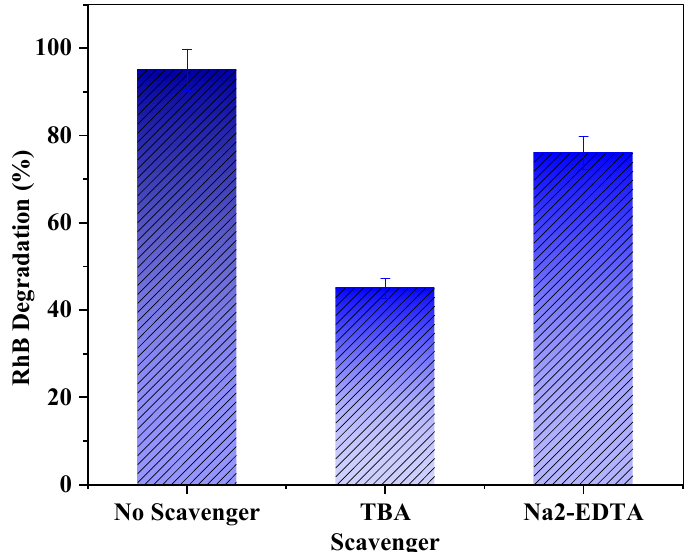
No Scavenger Figure 7. The photodegradation activity of Zn-TNTs in decontamination of RhB under visible-light irradiation in the existence of Na 2 -EDTA as hole scavenger and TBA as electron scavenger.